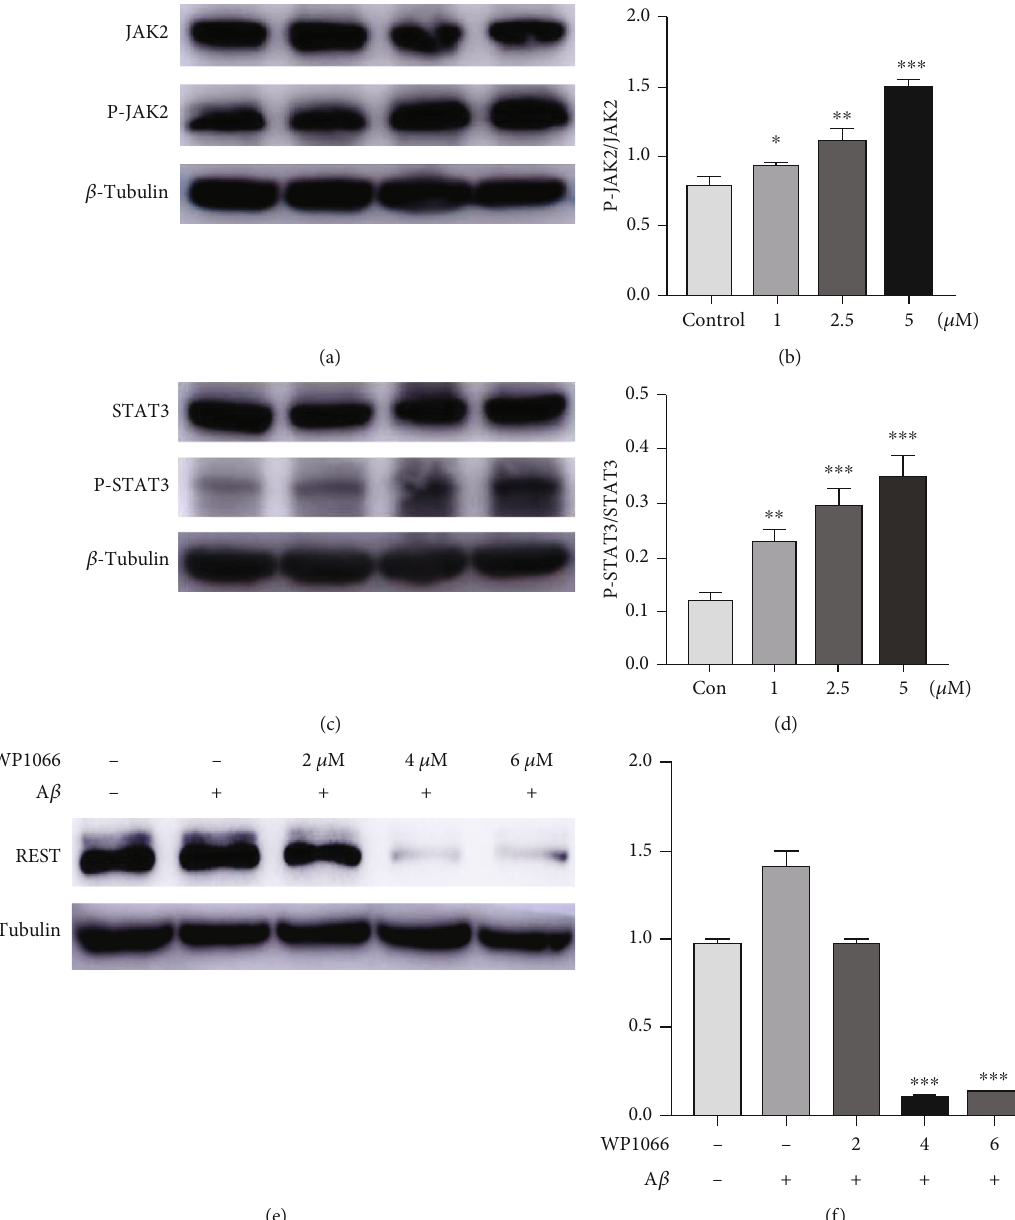
Figure 3: A β induced REST expression through JAK2/STAT3 pathway. (a, b) A β 1-42 promotes STAT3 phosphorylation. (e, f) Blocking JAK2/STAT3 signaling with WP1066 repressed A β 0 : 05 , ∗∗ p < 0 : 01 , ∗∗∗ p < 0 : 001